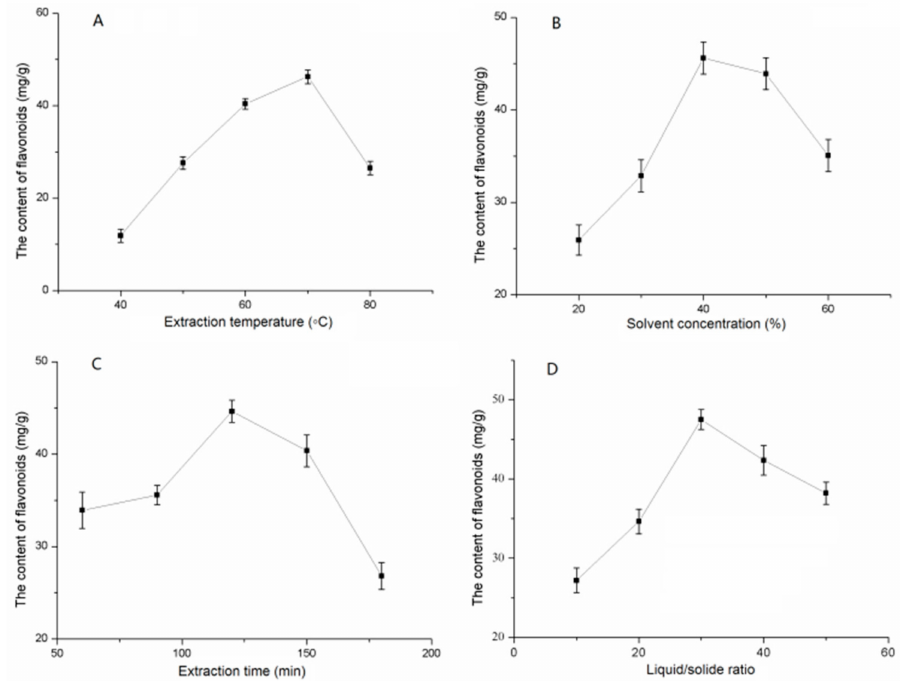
Figure 1. The e ff ect of single factors on the extraction of Morus alba L. leaves (MLF). ( A ) Extraction temperature ( ◦ C); ( B ) solvent concentration (%); ( C ) extraction time (min); ( D ) liquid / solid ratio. Data are shown as mean ± SD ( n = 3).